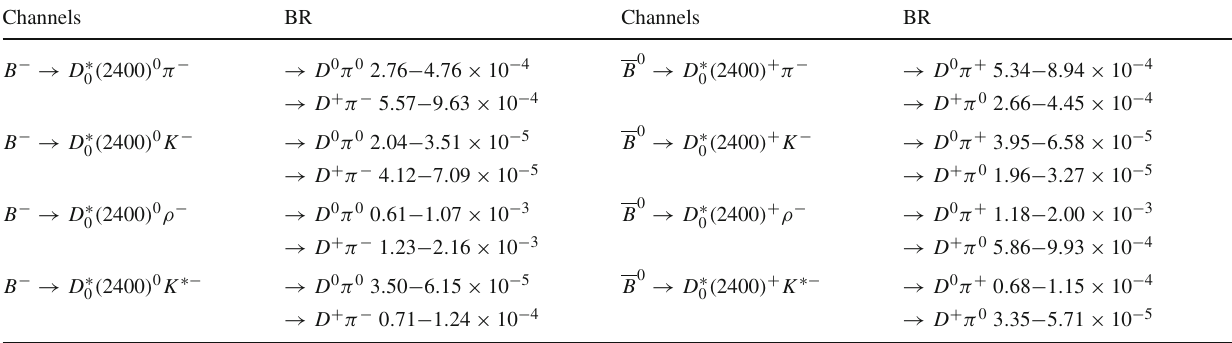
Table 6 The branching ratios of cascade decays to D π